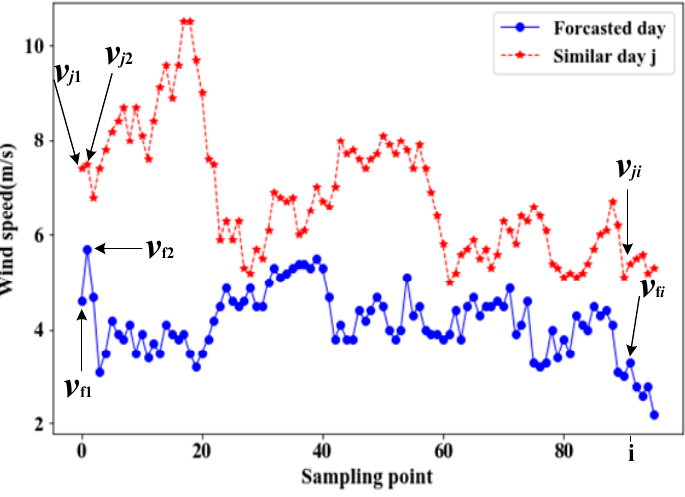
Figure 7. The wind speed of the forecasted day and similar days.